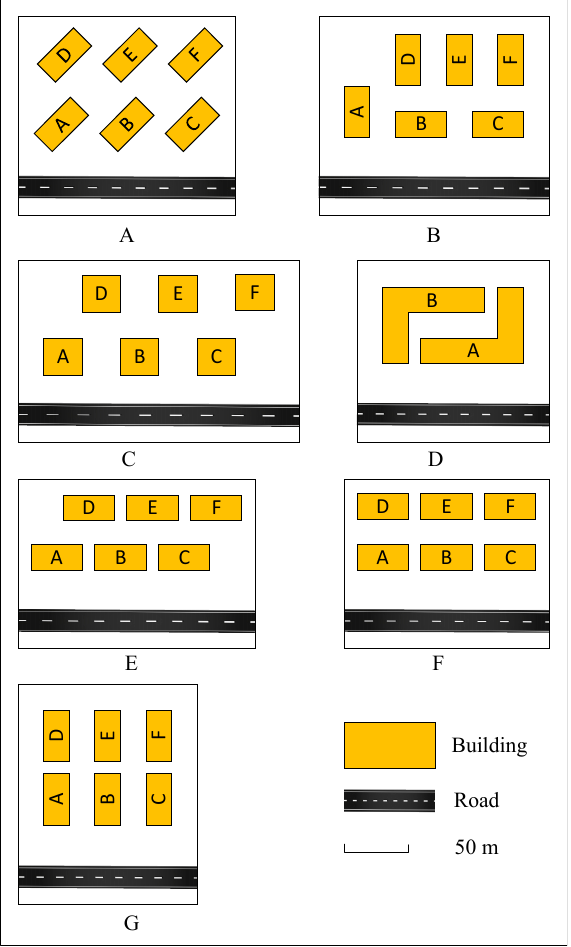
Figure 6. Seven layout patterns. ( a ) Pattern A; ( b ) Pattern B; ( c ) Pattern C; ( d ) Pattern D; ( e ) Pattern E; ( f ) Pattern F; ( g ) Pattern G.